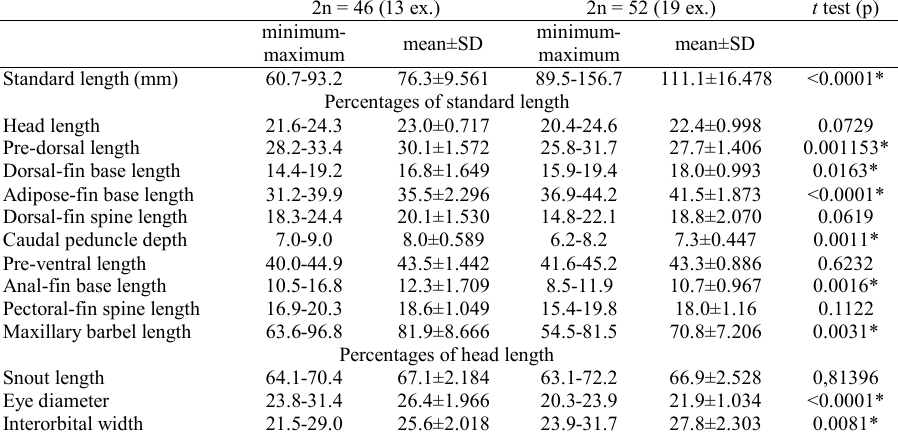
Table 2. Morphometry of Pimelodella with 2n = 46 (13 specimens) and Pimelodella with 2n = 52 (19 specimens. Except barbel with 18 specimens) from the Miranda River Basin, Pantanal, MS. SD = Standard deviation; * = Means significantly different. 2n = 46 (13 ex.)